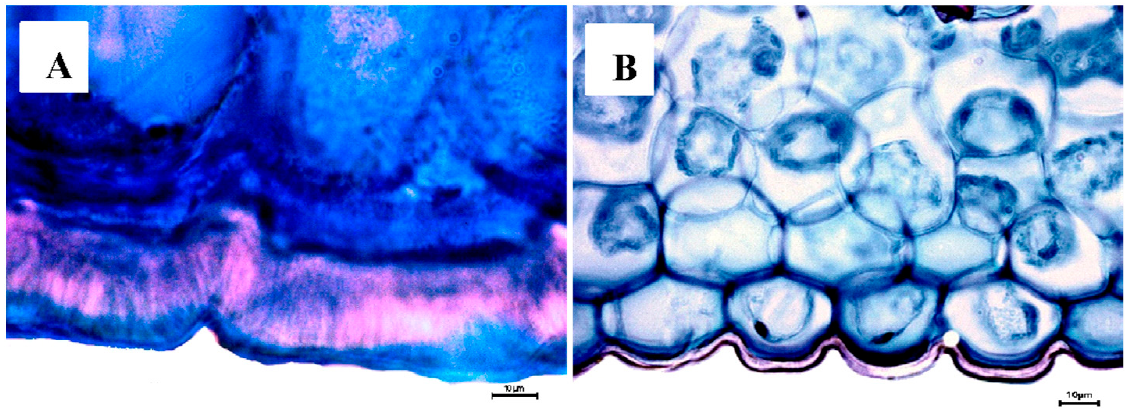
Figure 7. Abaxial cuticle thickness. ( A ) Cattleya mossiae ( ≥ 18 µ m). ( B ) Laelia crawshayana ( ≤ 18 µ